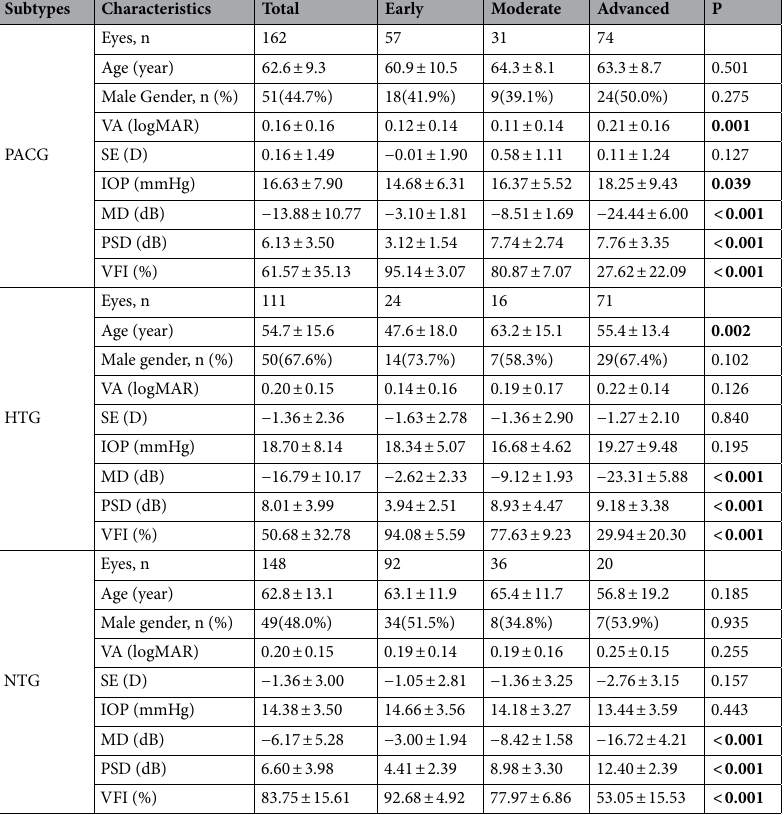
Table 1. Demographic characteristics of participants. Data are mean ± standard deviation unless otherwise indicated. VA visual acuity, SE spherical equivalent, IOP intraocular pressure, TD total deviation, MD mean deviation, PSD pattern standard deviation, VFI visual field index. Bold values: P <